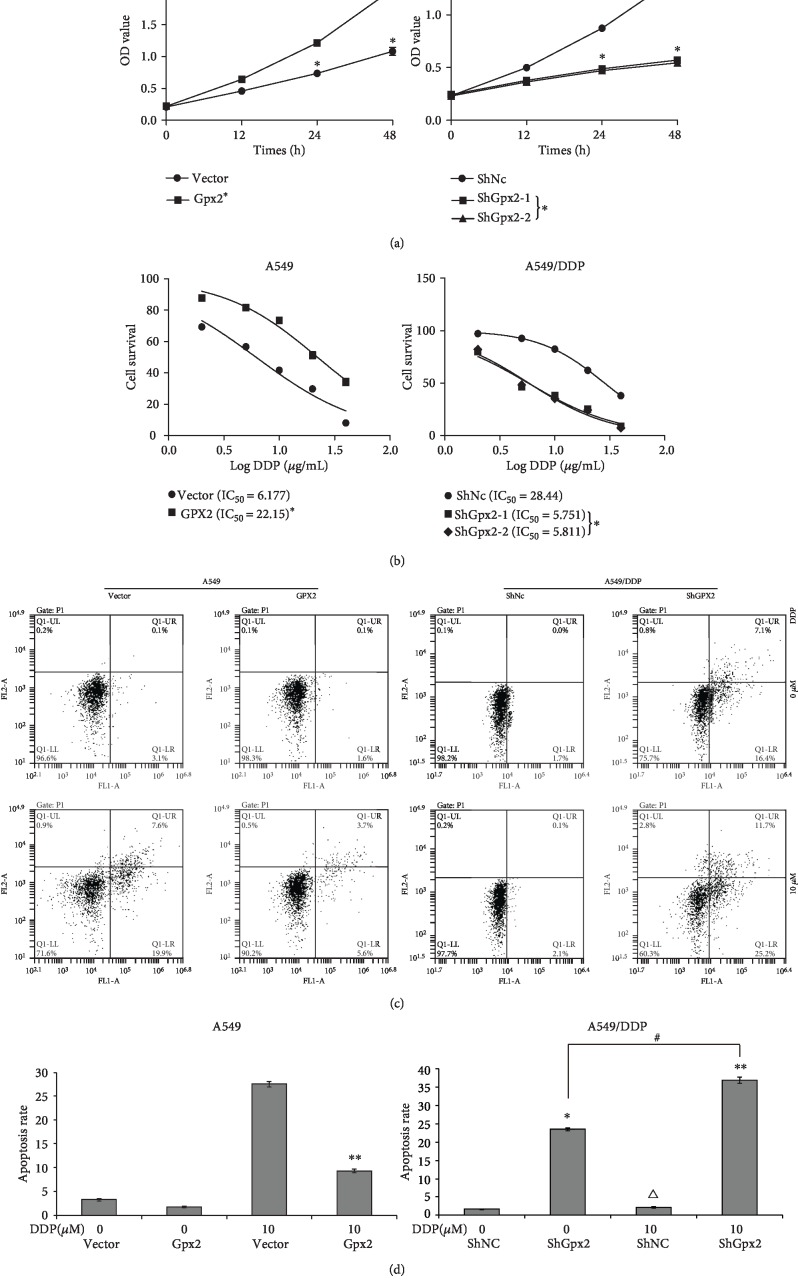

In vitro effects of GPX2 expression in DDP resistance. Using a CCK-8 assay, (a) cell proliferation and (b) the IC50 values of DDP were analyzed; ∗p < 0.05 vs. control. (c, d) Cell apoptosis was evaluated by flow cytometry, before and after 10 μM DDP treatment; ∗p < 0.05 vs. control (without DDP), ∗∗p < 0.05 vs. control (with DDP), △p > 0.05 vs. SiNC (without DDP), and #p < 0.05.